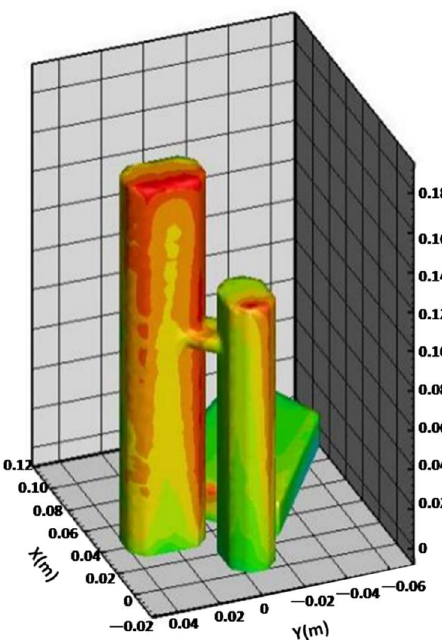
Figure 5. Sound pressure level nephogram.